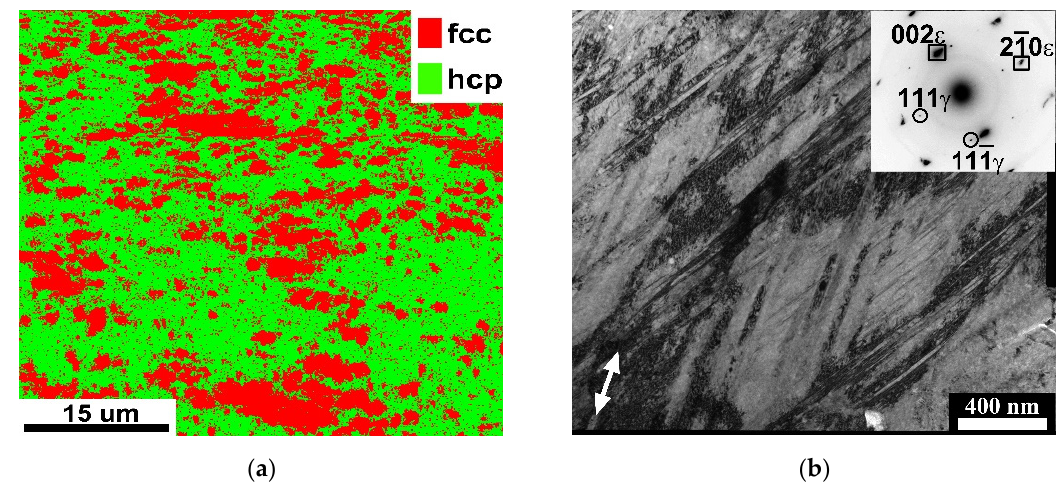
Figure 8. EBSD phase map ( a ), and bright-field TEM image ( b ) of the Fe 49 Mn 30 Co 10 Cr 10 C 1 alloy longitudinal 400-50 specimen tensioned to fracture. Selected area diffraction pattern indicating the presence of both γ and ε phases is inserted in ( b ). The applied load direction is indicated with the arrow in Figure 8b.